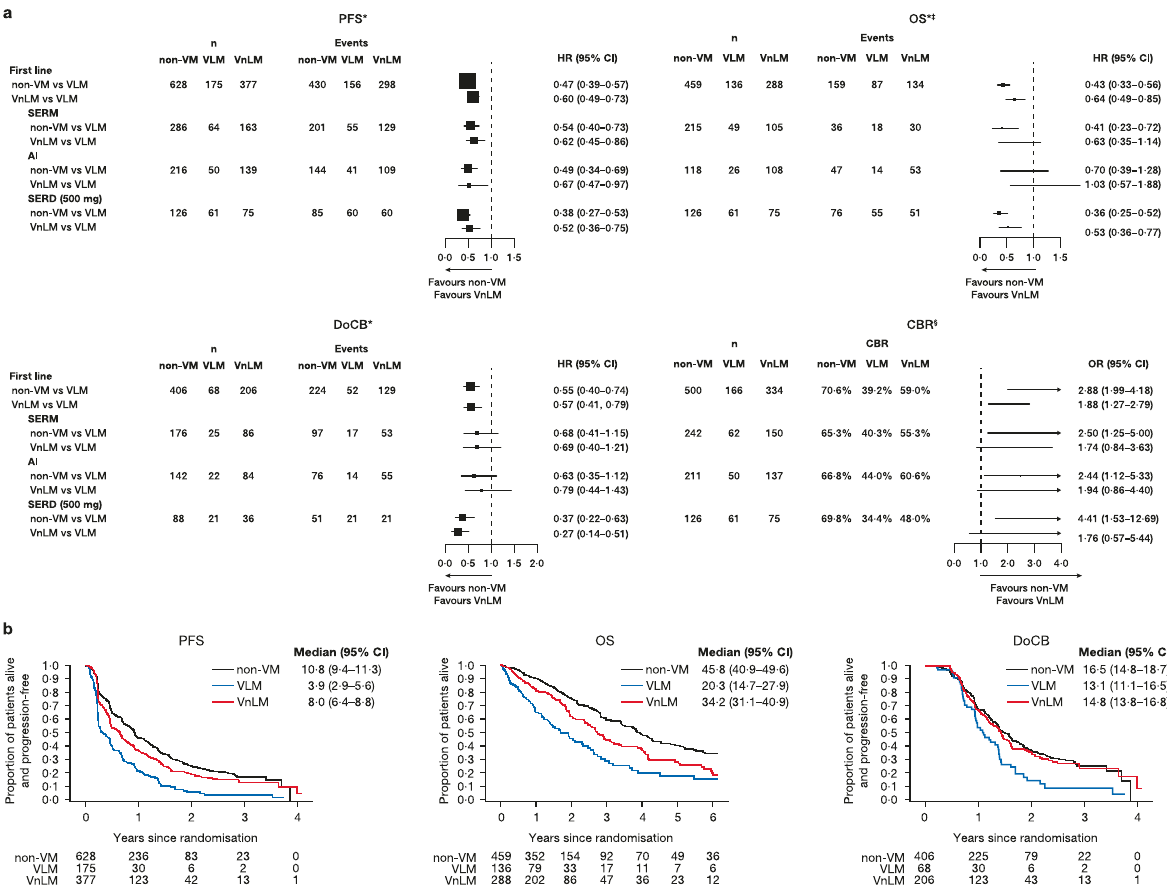
Fig. 4 Clinical outcome measures for non-VM and VnLM versus VLM in the fi rst-line setting. a Forest plots of PFS, OS, DoCB and CBR. Data for VLM are not available for the EORTC trial. *Fixed effect for trial was fi tted in all models. ‡ OS data for Study 0027 are based on aggregated mature survival data. § “ one − stage ” fi xed − effects logistic regression models. b Projected probability of PFS, OS and DoCB. Median (95% CI) PFS/OS/DoCB in months. AI aromatase inhibitor, CBR clinical bene fi t rate, DoCB duration of clinical bene fi t, HR hazard ratio, n number of patients, non-VM non-visceral metastases, PFS progression-free survival, OR odds ratio, OS overall survival, SERD selective estrogen receptor degrader, SERM selective estrogen receptor modulato, VLM visceral liver metastases, Non-VM non-visceral metastases, VnLM visceral non-liver metastases. Statistics for full models: VLM vs VnLM vs non-VM. PFS: SERM: Interaction test p = 0.55; AI: Interaction test p = 0.25; SERD: Interaction test p = 0.22; All: Interaction test p = 0.29. OS: SERM: Interaction test p = 0.42; AI: Interaction test p = 0.06; SERD: Interaction test p = 0.54; All: Interaction test p = 0.25. DoCB: SERM: Interaction test p = 0.81; AI: Interaction test p = 0.54: SERD: Interaction test p = 0.07; All: Interaction test p = 0.07. CBR: SERM: Interaction test p = 0.26; AI: Interaction test p = 0.05; SERD: Interaction test p = 0.85; All: Interaction test p =